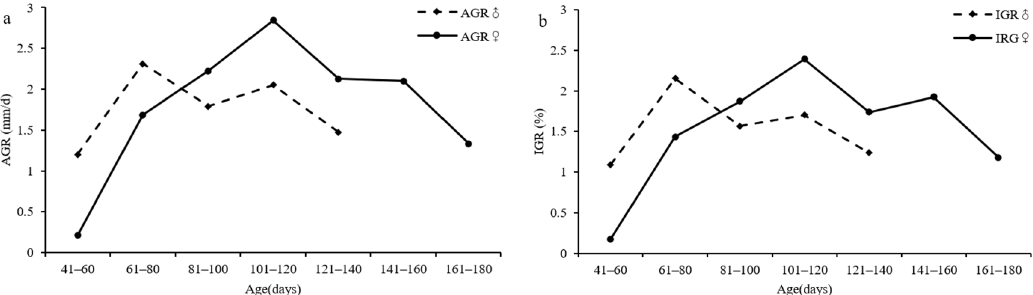
Figure 8. Relationships between the ML growth rate and age of B. magister shevtsovi samples: ( a ) AGR; ( b ) IGR.